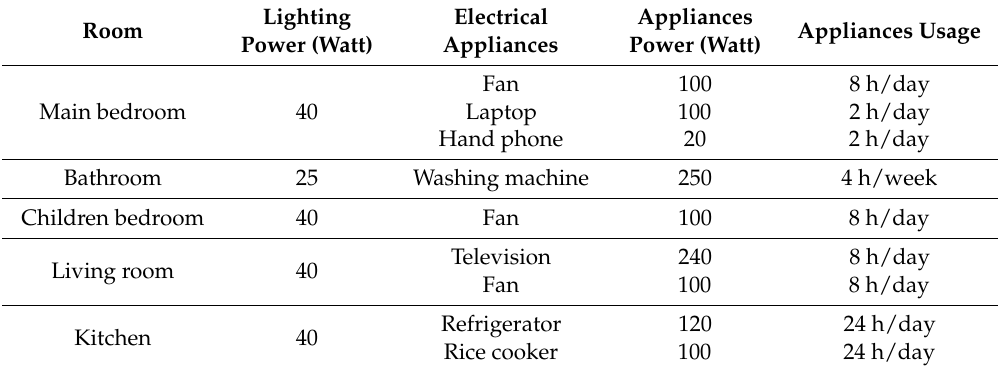
Table 17. Lighting, electrical appliances list and the usage.